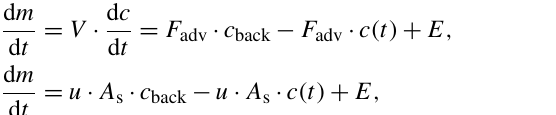
(Figs. S15–S17) emission estimates in the same range